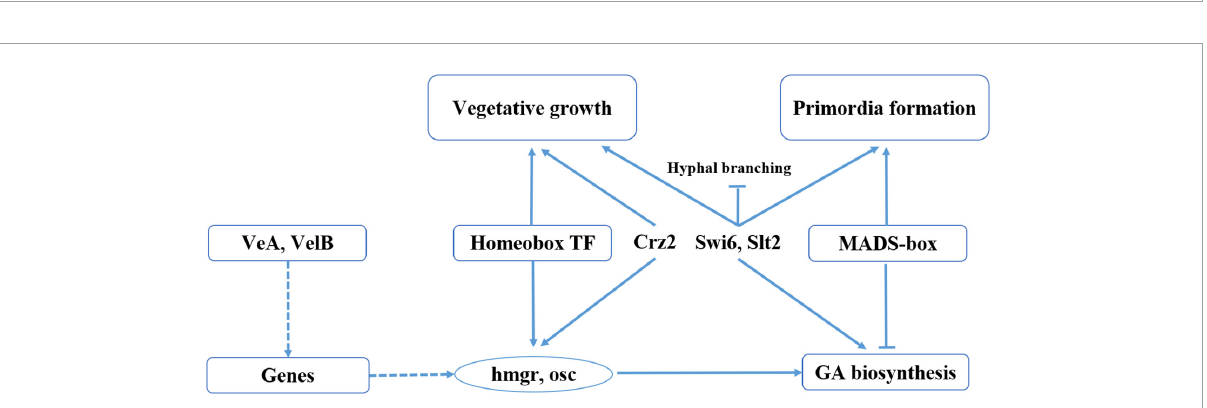
FIGURE7 Model of regulation of fruiting body development and GA biosynthesis in G. lucidum . Solid lines represent the determined regulatory effect, dotted lines represent the regulatory effect of an unknown regulatory mechanism, arrows represent the facilitated effect, and short lines represent